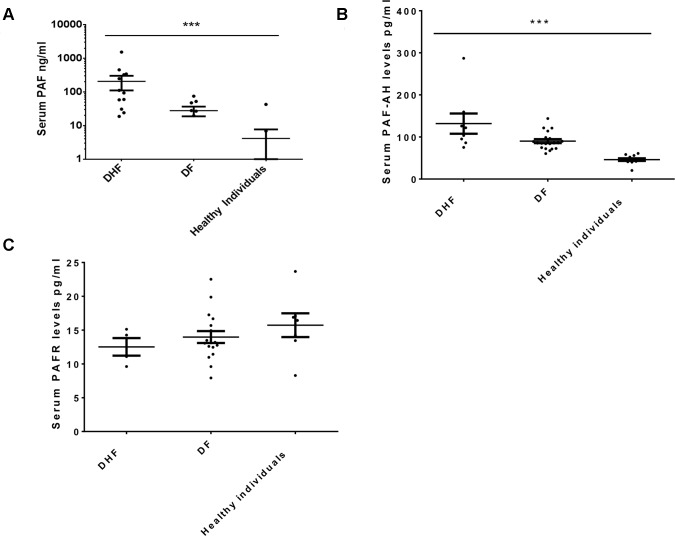
PAF, PAF-AH and PAF-R levels in patients and healthy individuals.A: PAF levels in sera of patients with DHF (n = 16), DF (n = 9) and healthy individuals (n = 12). The bars represent the mean and the standard error of mean; p = 0.002. B: PAF-AH levels in sera of patients with DHF (n = 16), DF (n = 9) and healthy individuals (n = 12). The bars represent the mean and the standard error of mean; p<0.0001. C: PAFR levels in sera of patients with DHF (n = 16), DF (n = 9) and healthy individuals (n = 12). The bars represent the mean and the standard error of mean; p = 0.33.